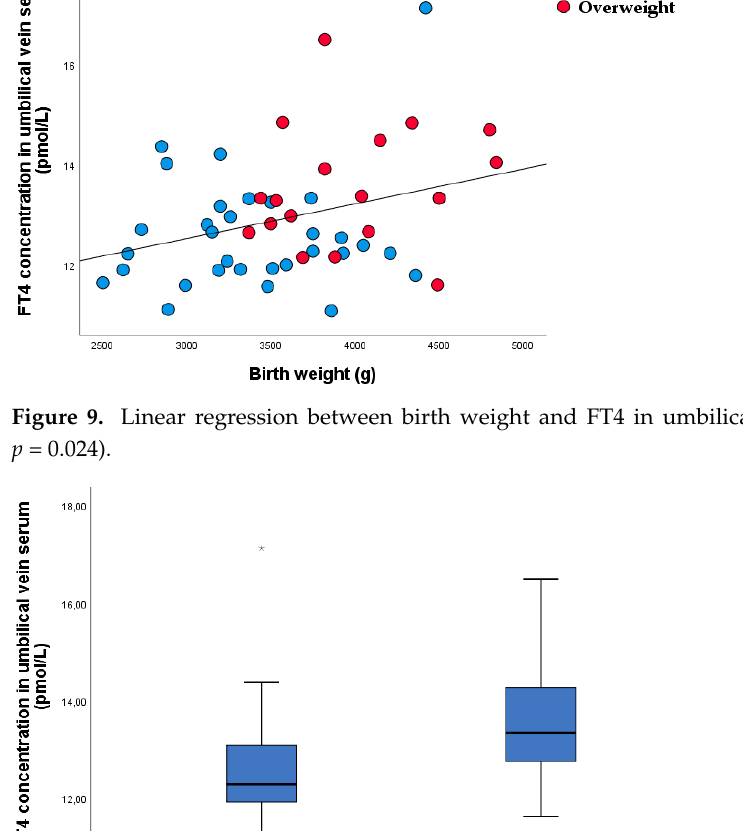
serum FT4 concentration (r = 0.320, p = 0.024) (Figure 9).